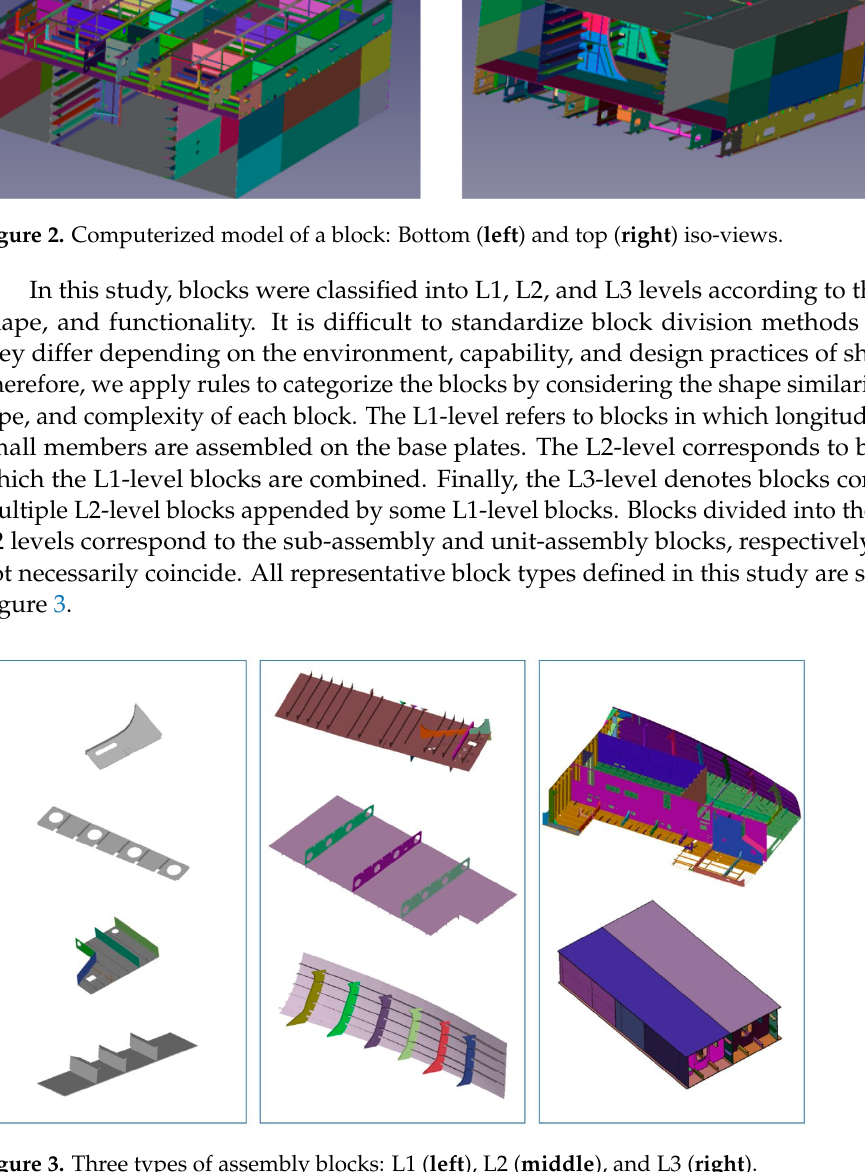
Figure 3. Three types of assembly blocks: L1 (left), L2 (middle), and L3 (right).